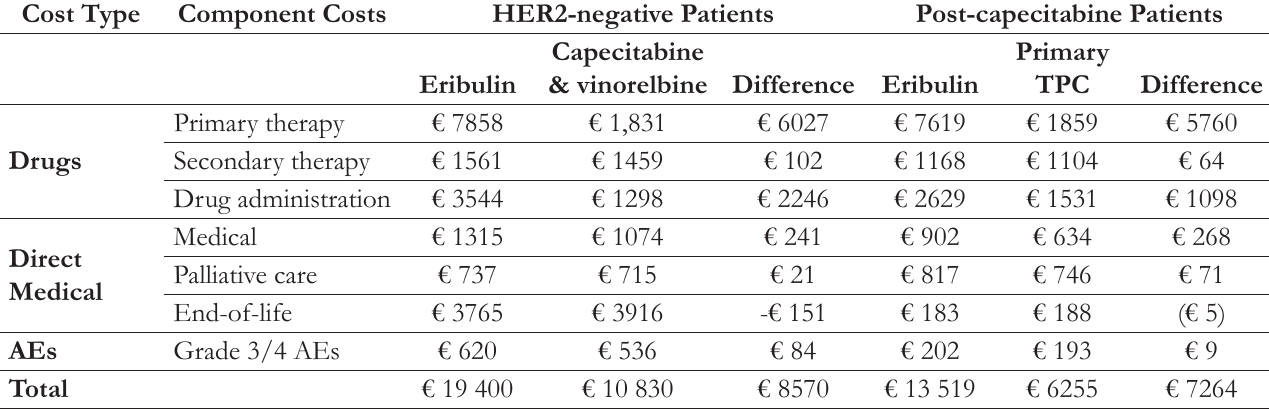
Table 4. Total Discounted Costs 18,20,21